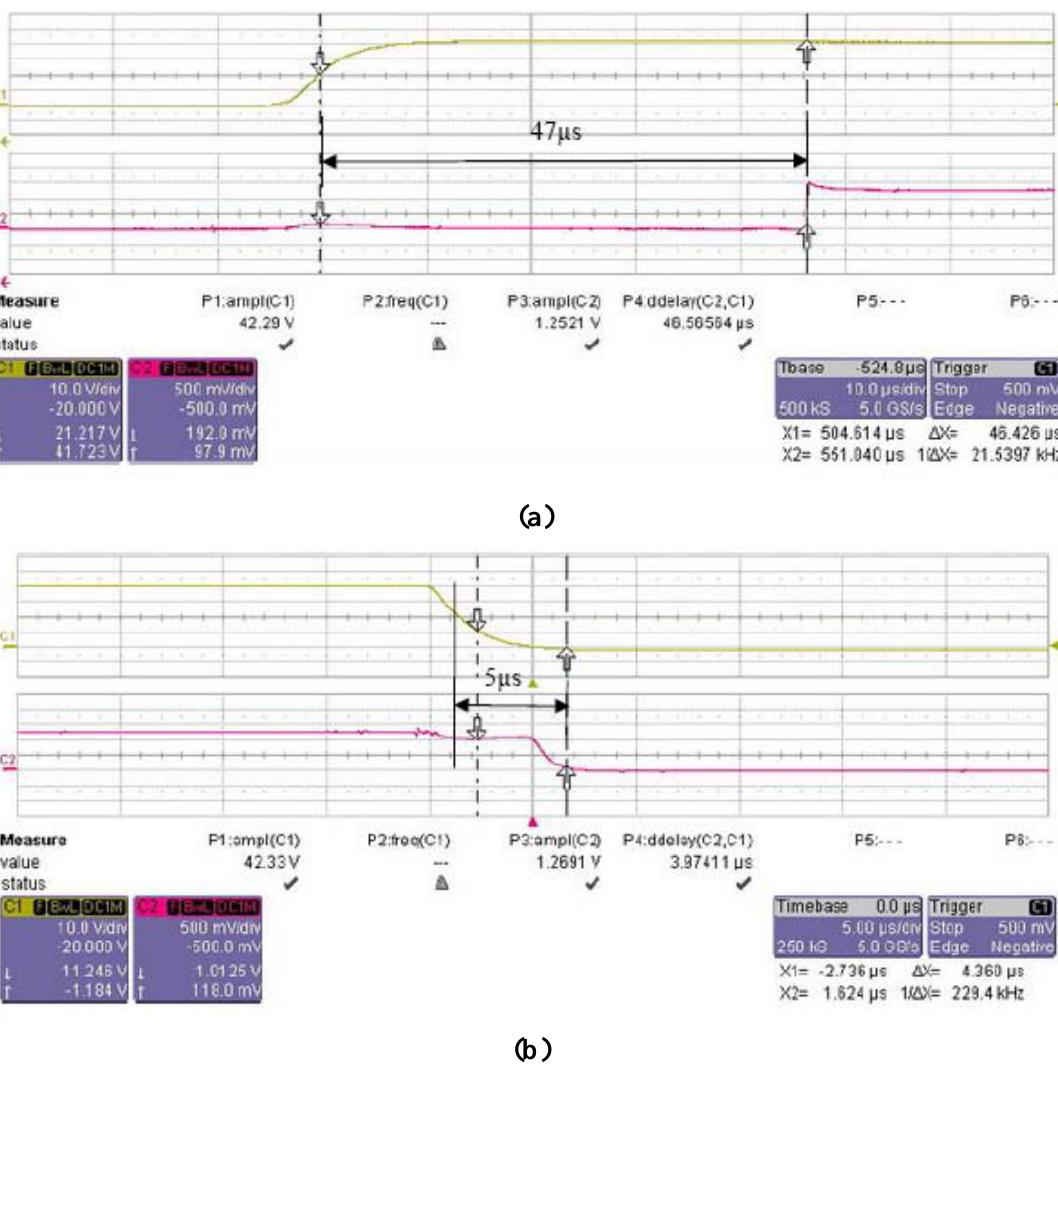
Figure 2. Measurements of switching on/off time: (a) at rising and (b) falling